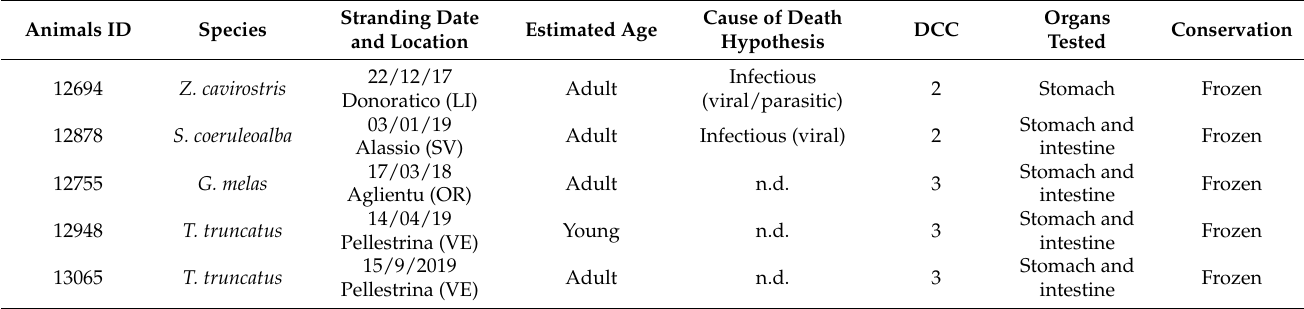
Table 1. Biological and stranding information, hypothesis of the cause of death and organs tested. ID of animals refers to the Italian Stranding Database [27], DCC: decomposition condition code, which is the stage of decomposition of the carcass at the necropsy [6]; n.d.: not determined.